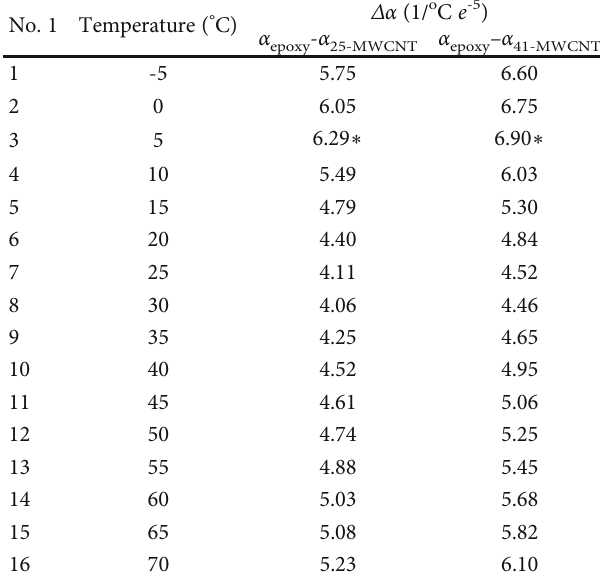
Table 3: CTE di ff erences between 25-MWCNT and epoxy and between 41-MWCNT and epoxy ( Δα ) at a temperature range of -5 ° C and 70 °